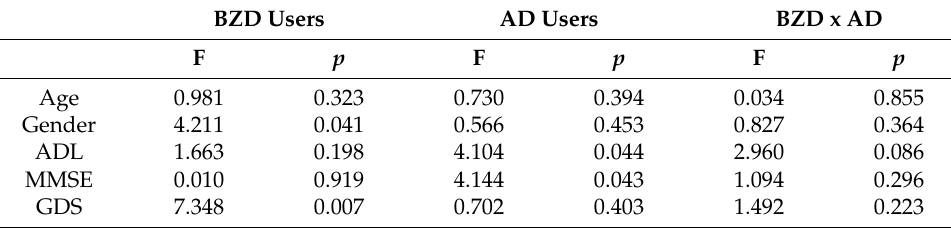
Table 3. GLM univariate analysis: Benzodiazepine users compared with antidepressant